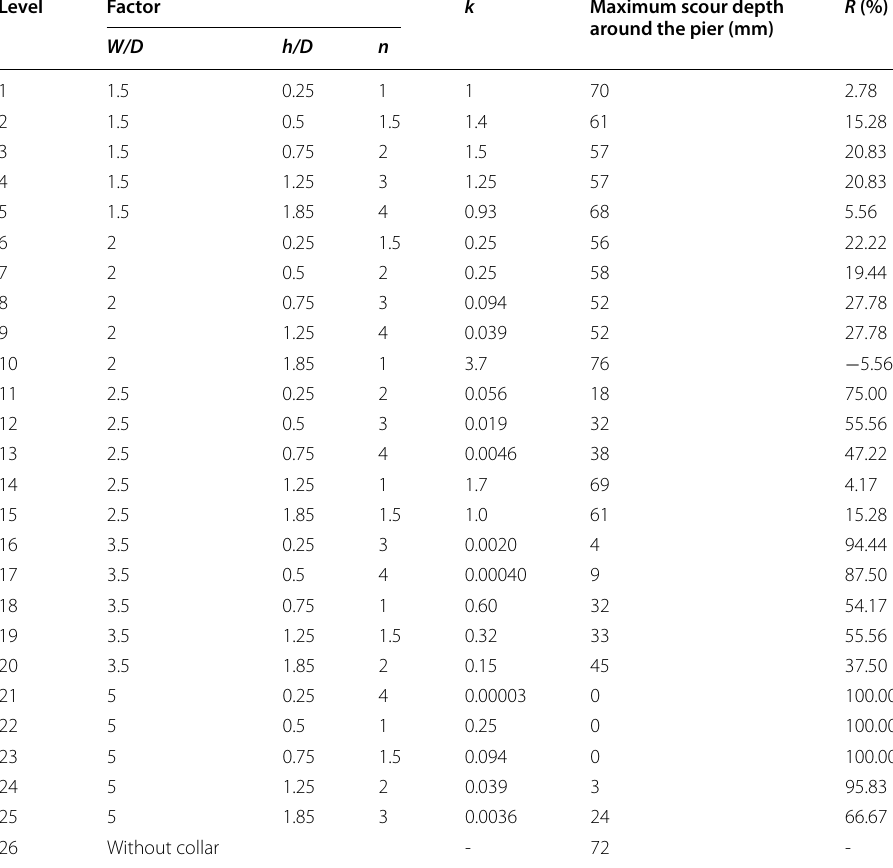
Table 4 Test results and calculated values of R